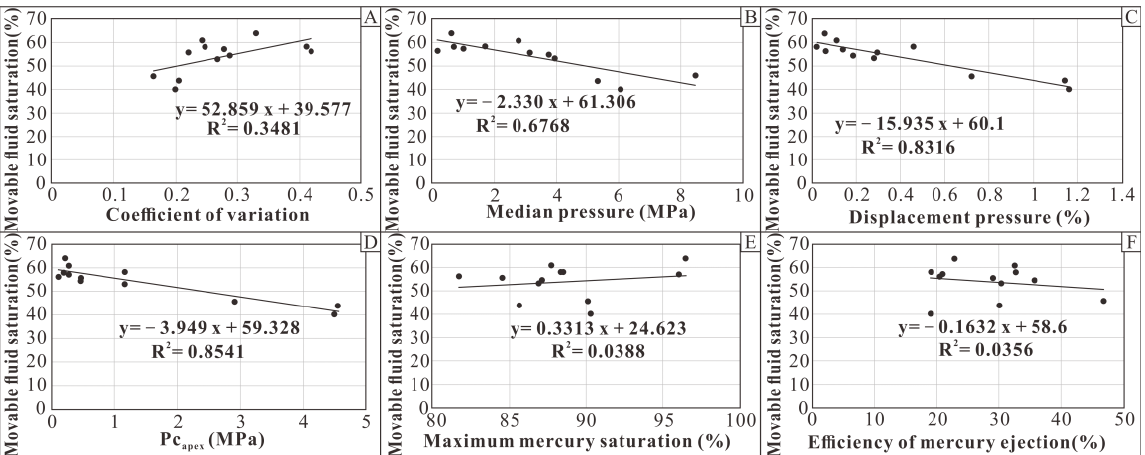
Figure 22. Correlation between pore-throat structure parameters and movable fluid saturation. ( A ) Correlation between coefficient of variation and movable fluid saturation. ( B ) Correlation between median pressure and movable fluid saturation. ( C ) Correlation between displacement pressure and movable fluid saturation. ( D ) Correlation between Pc apex and movable fluid saturation. ( E ) Correlation between maximum mercury saturation and movable fluid saturation. ( F ) Correlation between efficiency of mercury ejection and movable fluid saturation.